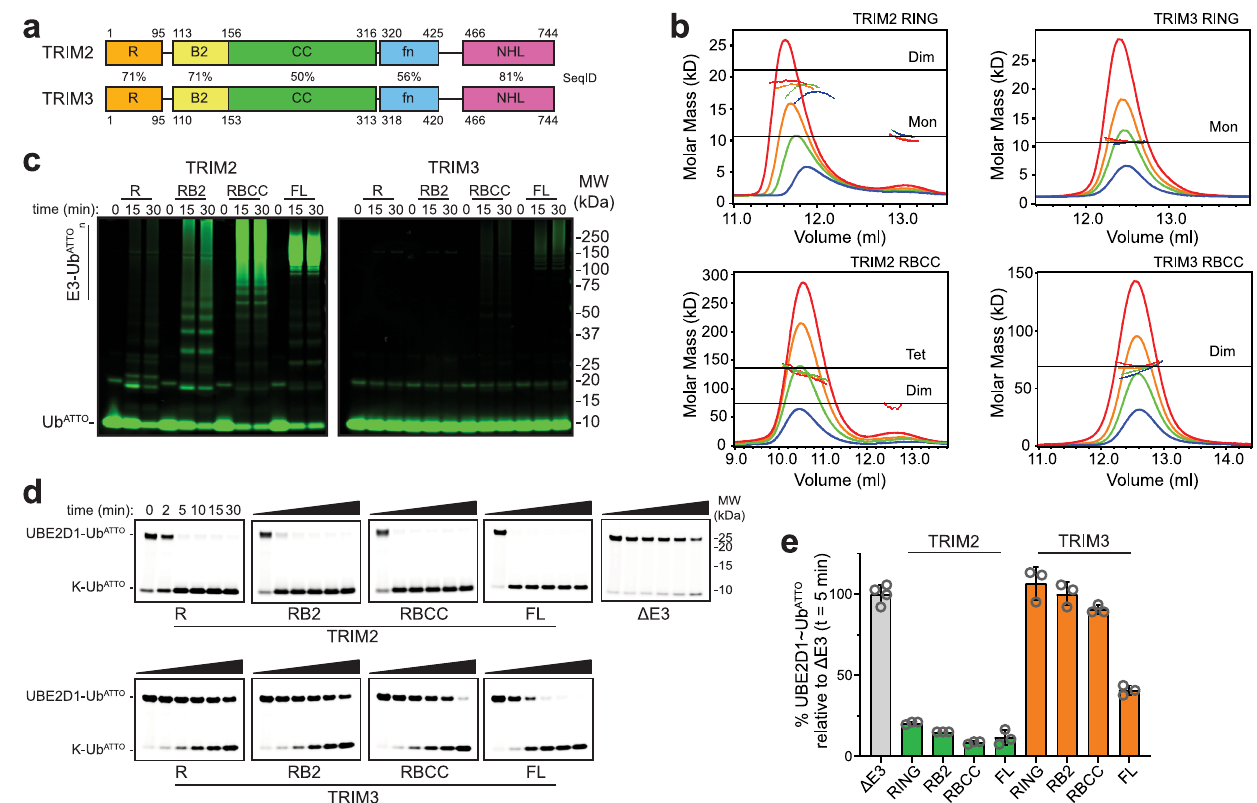
Fig. 1 | TRIM2 and TRIM3 oligomeric state and catalytic activity. a Domain organization of the E3 ligases. The numbering is based on the constructs used in this study for the RING (R), RING-B-box2 (RB2) and tripartite motif (RBCC), the TRIM2 fi lamin (fn) and TRIM3 fi lamin boundaries are based on the TRIM3 fn NMR structure (7O0B) and NHL boundaries on the TRIM2 (7QRV) and TRIM3 (7QRW) NHL domain crystal structures. Domains primary sequence identity (SeqID) is reportedinbetweenthecartoonrepresentation. b SEC-MALLSanalysisofdifferent constructs of TRIM2 and TRIM3. The proteins were analyzed at a concentration of 5 (red), 3 (orange), 2 (green) and 1mg/ml (blue). c Auto-ubiquitination and